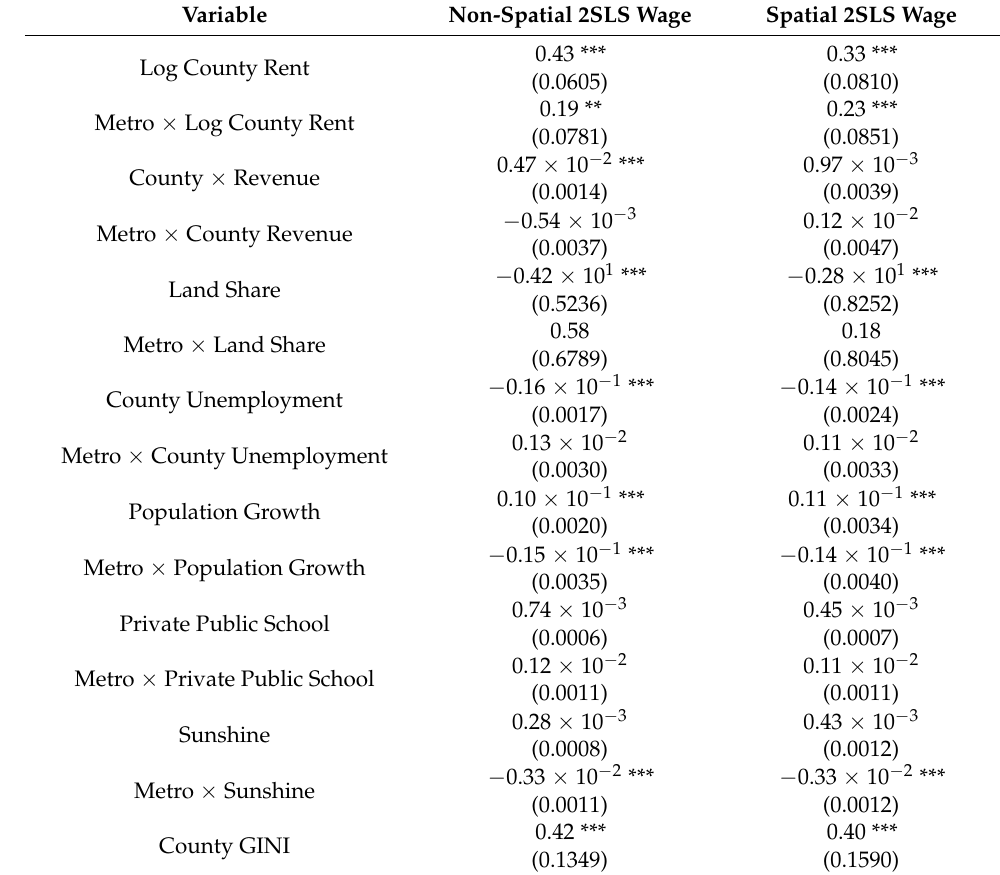
Table A15. Second-stage results for wage equations with a metro dummy and cross-products for the continental United States: non-spatial versus spatial